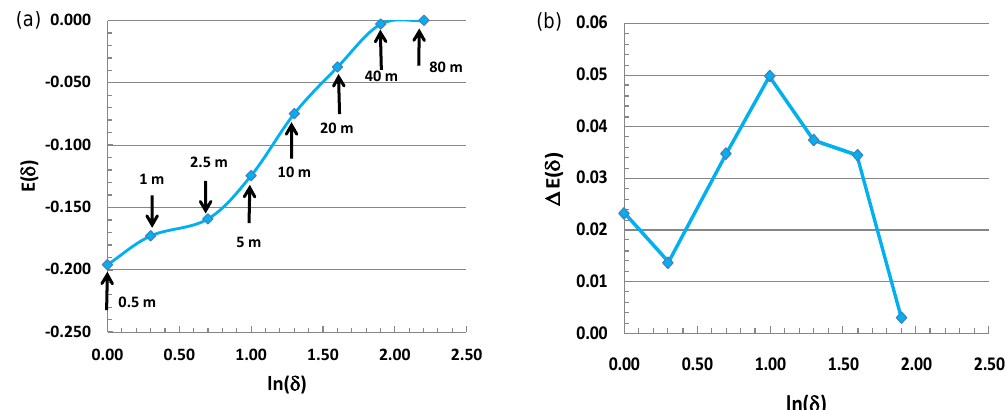
Figure 7. Entropy study: (a) relative entropy, E(δ) , of nitrogen applied (N app ); (b) increment of relative entropy, (cid:49)E(δ) , of N app . The equivalent distance to the number of data points ( δ) is marked in E(δ) .